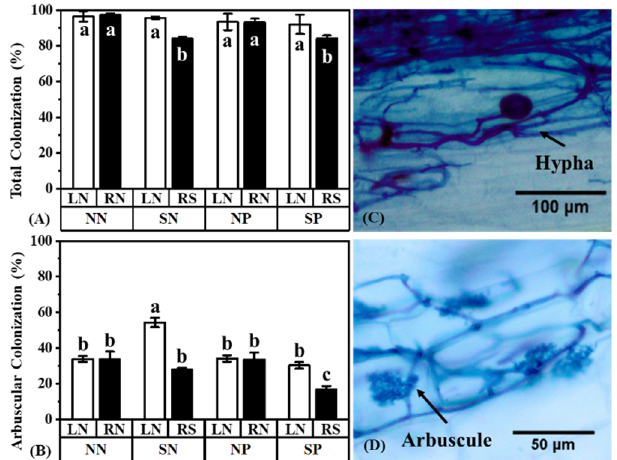
Figure 3. Effects of Pb and shading on the total colonization ( A ), arbuscular colonization ( B ), and the morphology of AM fungi ( C , D ) in M. alba . F and p -value of ANOVA are listed in Supplementary Table S3. Different letters above the columns in each graph indicate a significant difference among the means by Tukey’s test ( p < 0.05 ). The abbreviation is consistent with Figure 1.